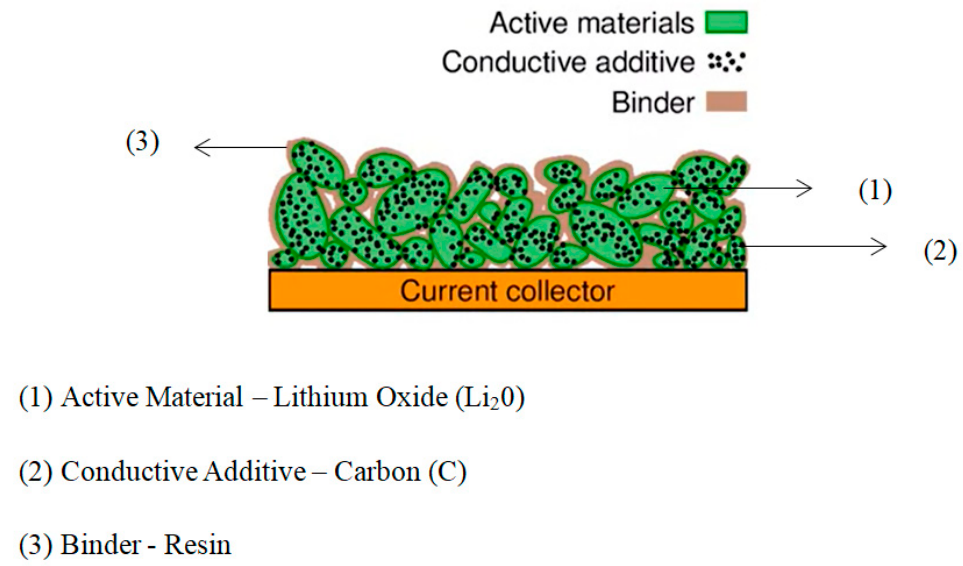
Figure 6. Composite materials in an electrode.